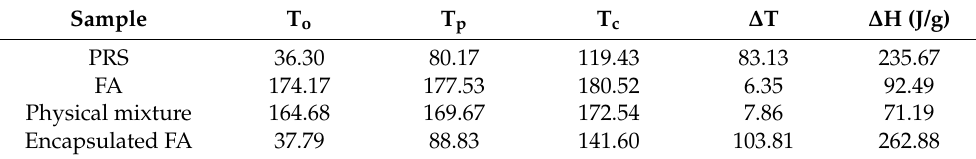
Figure 4. DSC curves of PRS, FA, physical mixture, and encapsulated FA. Table 2. DSC data of PRS, FA, physical mixture, and encapsulated FA.